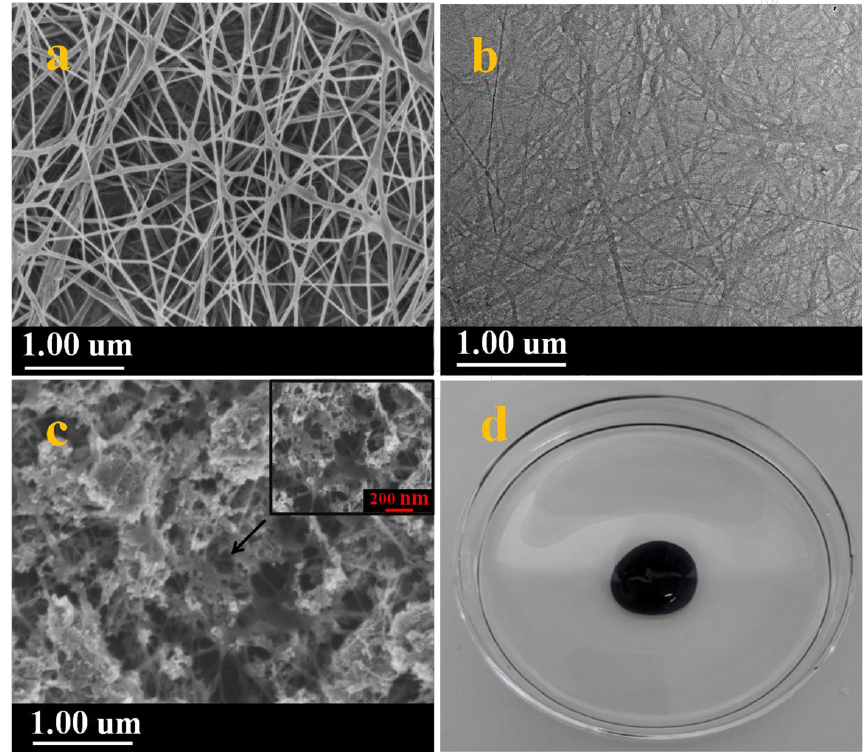
Figure 5. ( a ) FESEM images of pure BC synthesized in shaking culture system; ( b ) TEM image of BC; ( c ) FESEM images of BC/c-MWCNTs composite membranes; and ( d ) digital photos of c-MWCNTs-dispersed HS medium a shaking culture system at 30 °C for 6 days (100 rpm).